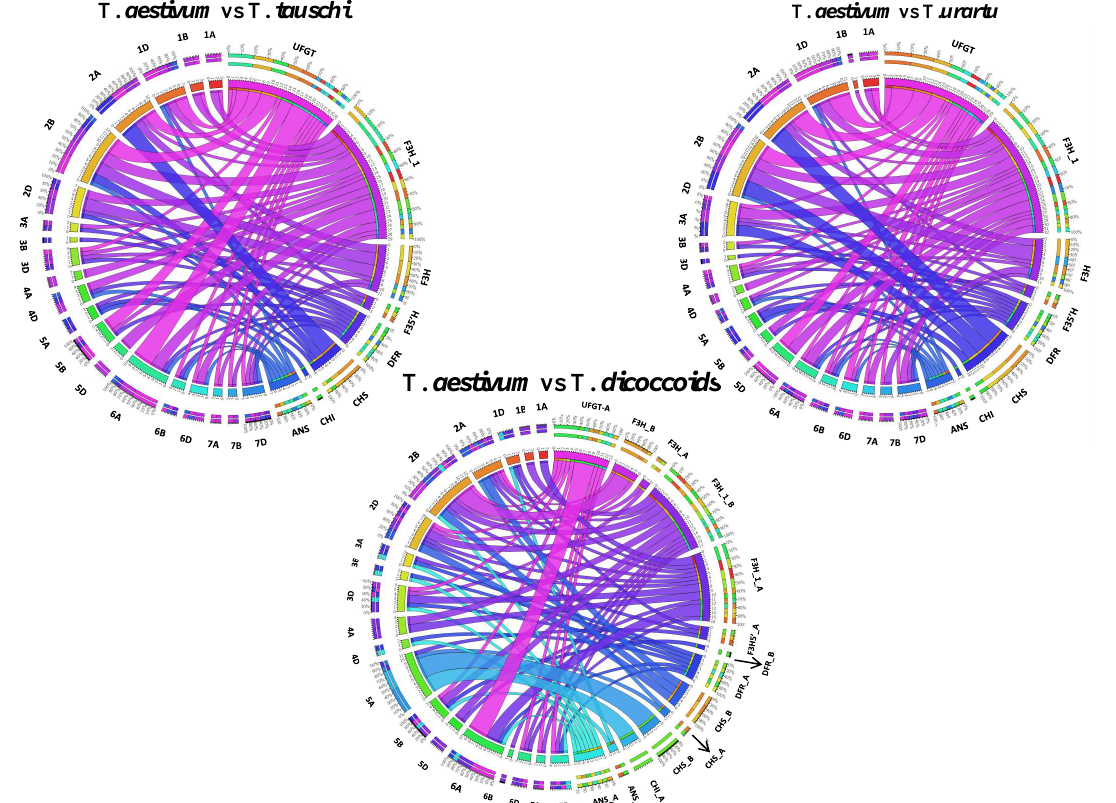
Figure 8. Syntenic relationship of target genes orthologous with their close relatives, Ae. tauschii , T. urartu and T. dicoccoides . Chromosomes represent the respective ancestral parent genome ( tauschii / urartu / dicoccoides ) and gene names represent the T. aestivum genome